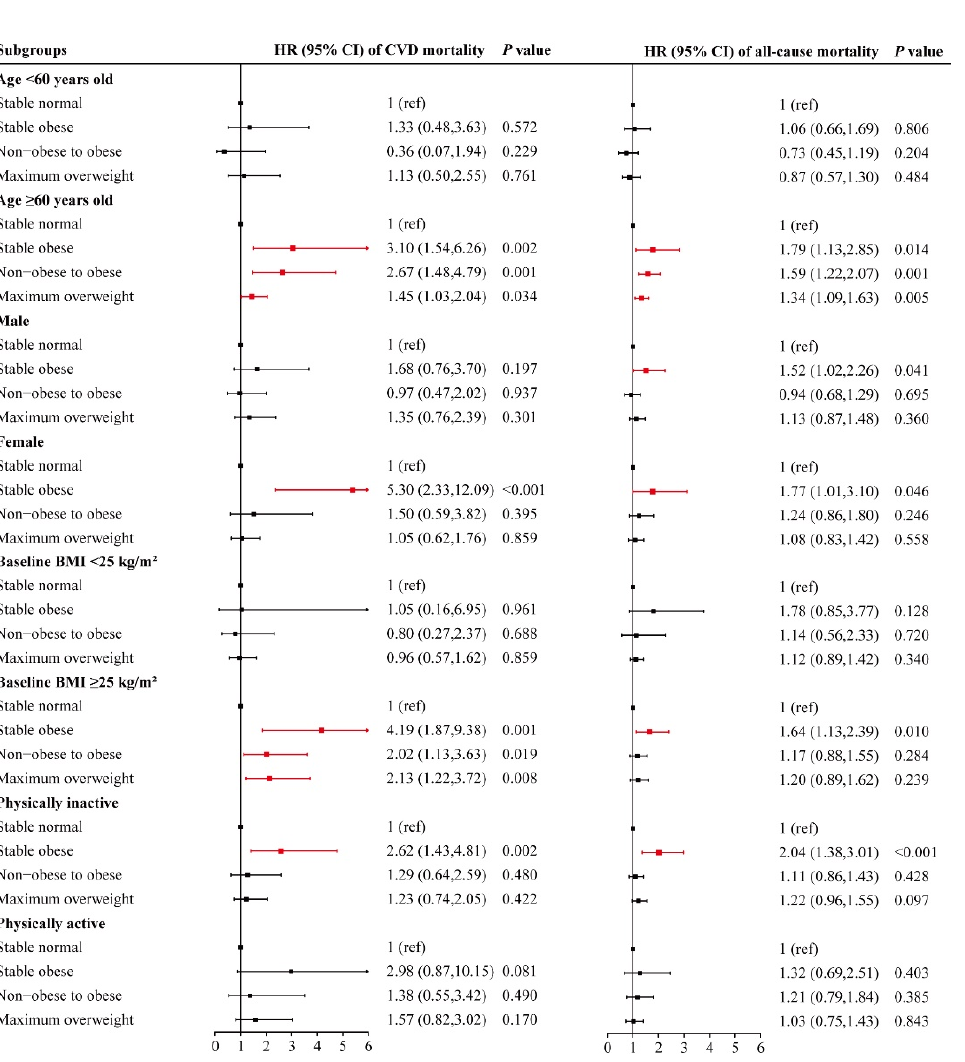
Figure 2. Associations between early-adulthood weight change pattern and CVD, all-cause mortality stratified by age, sex, baseline BMI and physical activity. HRs were adjusted for age (not adjusted in subgroup analysis by age), sex (not adjusted in subgroup analysis by sex), race/ethnicity, education, family income, baseline BMI (not adjusted in subgroup analysis by baseline BMI), physical activity (not adjusted in subgroup analysis by physical activity), total cholesterol, HDL cholesterol, carbohydrate intake, dietary fiber, protein intake, fat intake, energy intake, alcohol drinking status, smoking status, hypertension and diabetes in the analysis for CVD mortality.